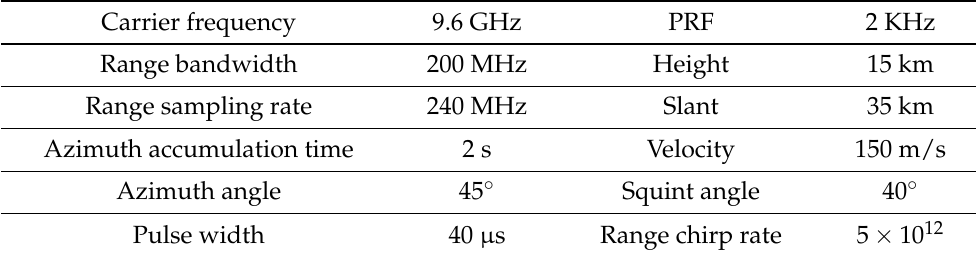
Figure 10. Ship model diagram. Table 1. SAR system parameters. A linear FM signal is used for